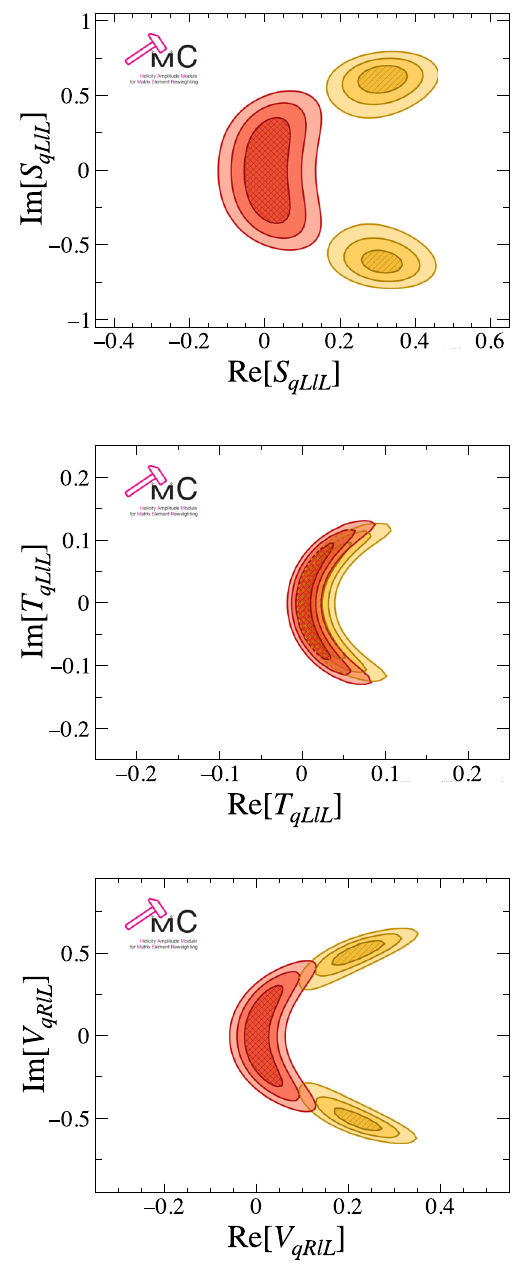
Fig. 4 The68%,95%and99%CLallowedregionsofthethreemodels underconsideration,fromfittingtheSM(red)and2HDMtypeII(yellow and with S qRlL = − 2) Asimov data sets. (Top) R 2 leptoquark model with S qLlL = 8 T qLlL ; (middle) NP in the form of a left-handed tensor coupling; (bottom) NP in the form of a right-handed vector